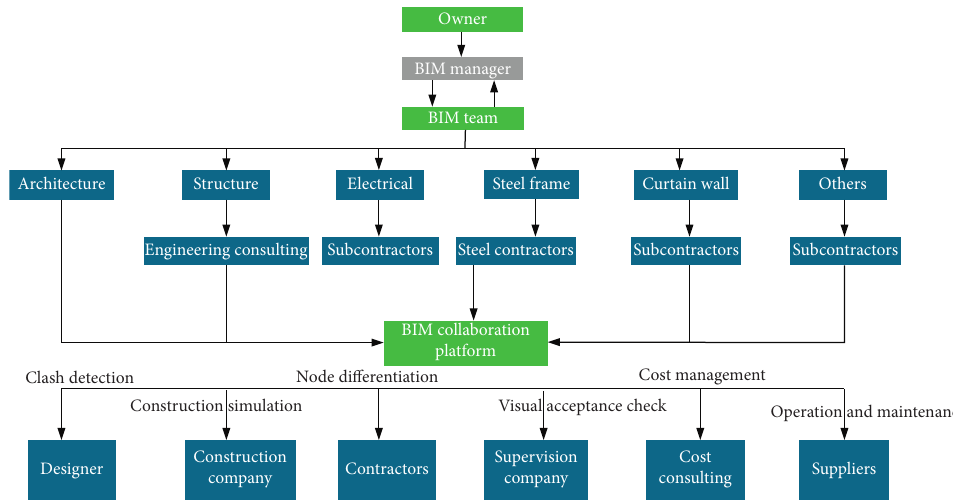
Figure 1: The design flow chart of BIM management for owners.